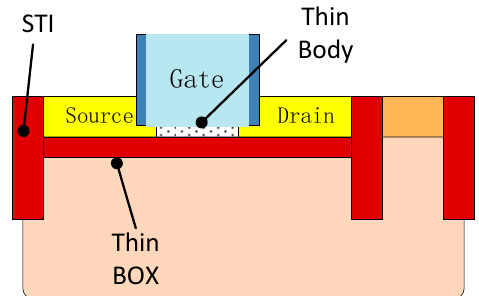
Figure 2. A ST28 ultra-thin buried oxide and body fully depleted silicon on insulator (SOI) transistor.